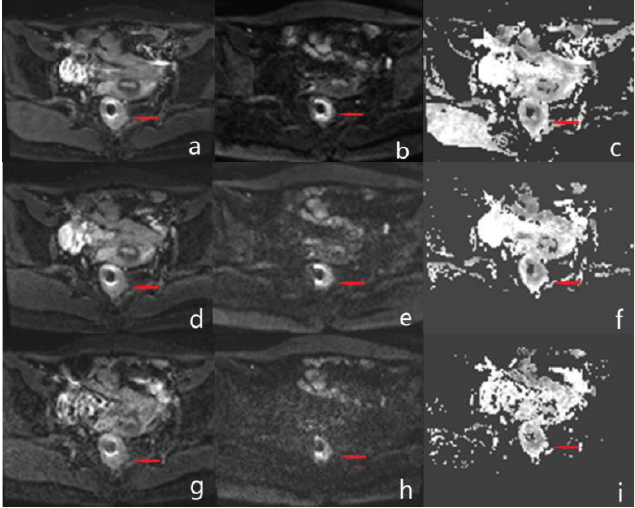
Figure 3. Male, 53 years old with rectal cancer. ( a – c ) Diffusion-weighted and ADC maps of conven- tional rs-EPI sequences with b-values of 0 s/mm 2 and 1000 s/mm 2 , respectively. ( d – f ) Diffusion- weighted and ADC maps of 2× SMS rs-EPI sequences with b-values of 0 s/mm 2 and 1000 s/mm 2 , respectively. ( g – i ) Diffusion-weighted and ADC maps of 3 × SMS rs-EPI sequences with b-values of 0 s/mm 2 and 1000 s/mm 2 , respectively. The arrow in the figure points to a rectal cancer